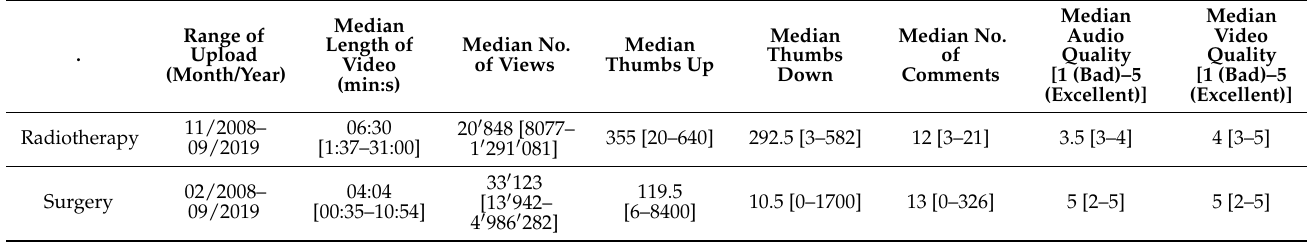
Table 1. Basic characteristic of included videos, grouped by type of treatment (radiotherapy or surgery). (Numbers are reported as median [range] unless indicated otherwise).